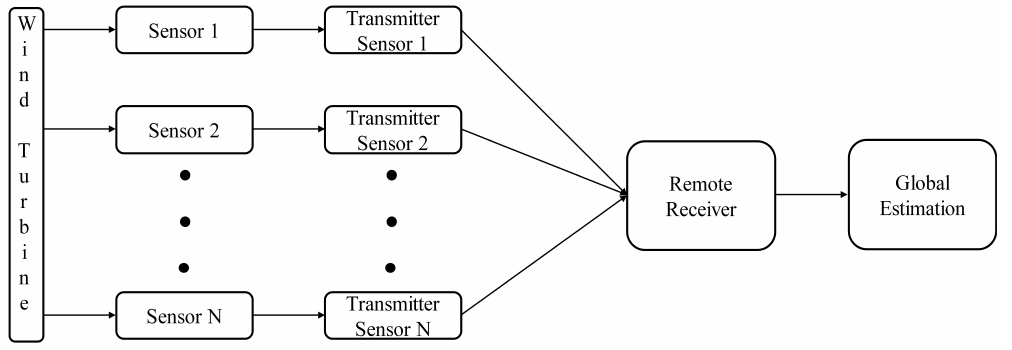
Figure 2. Communication framework of multi-sensor wind